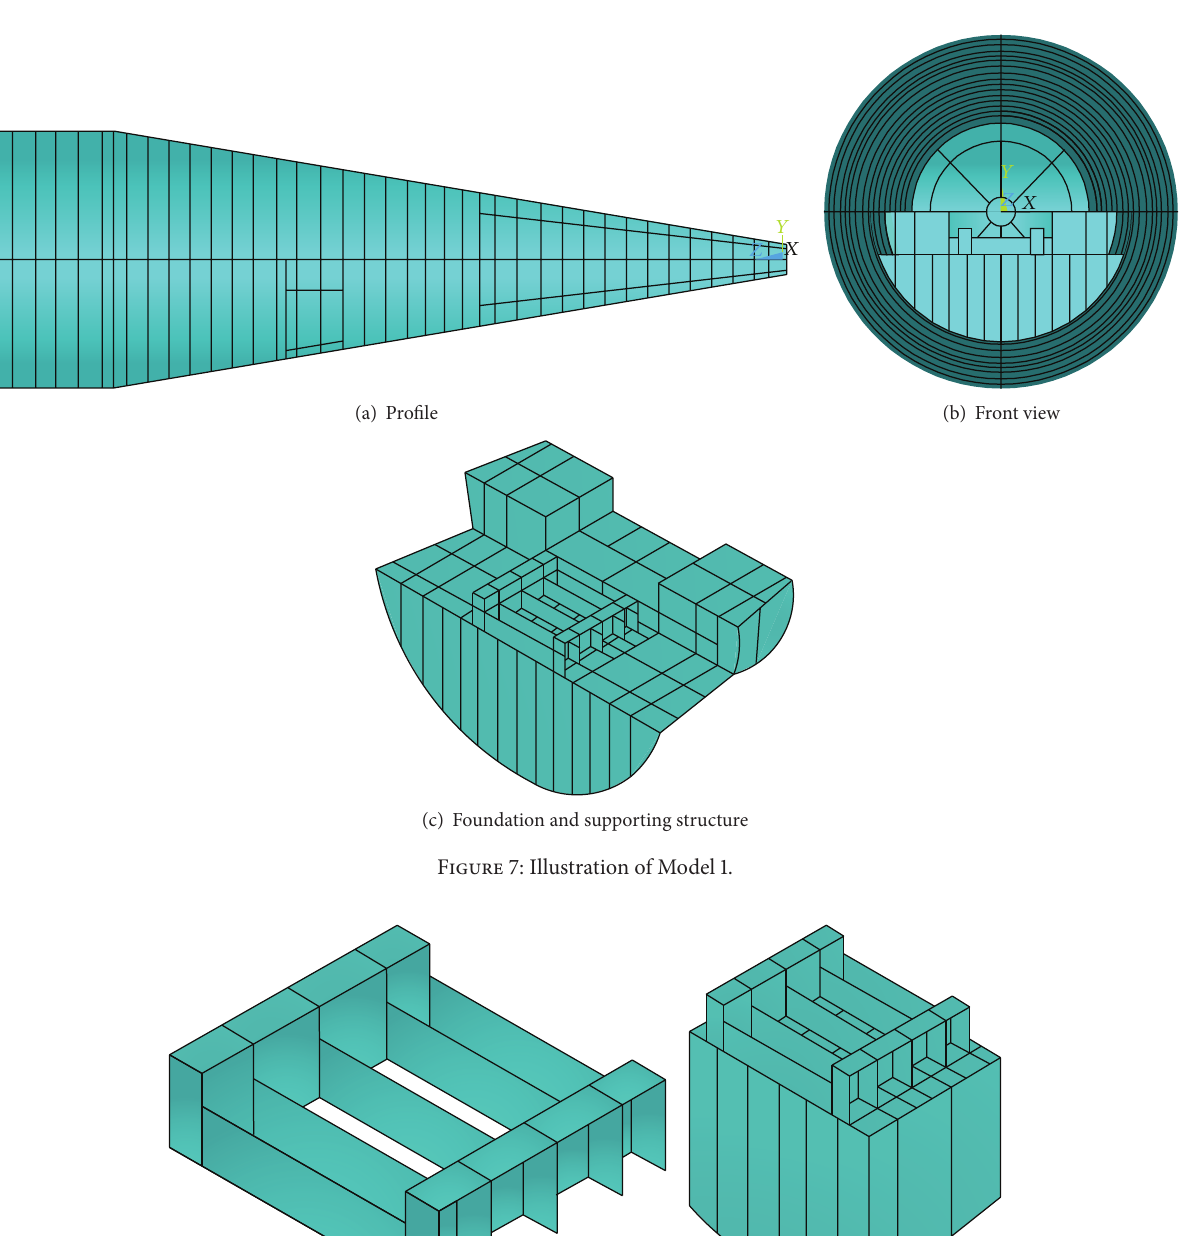
Figure 8: Illustrations of Model 2 and Model